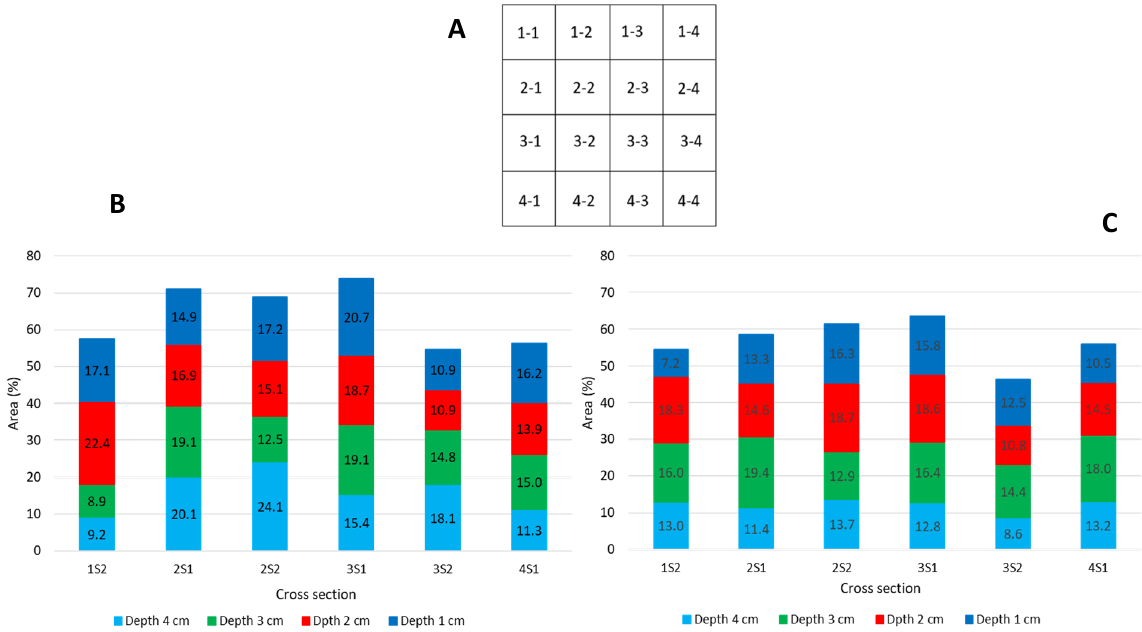
Figure 16. Division in 16 parts of a cross-section ( A ), areas occupied by fibers in dynamic compaction ( B ) and static compaction ( C ).